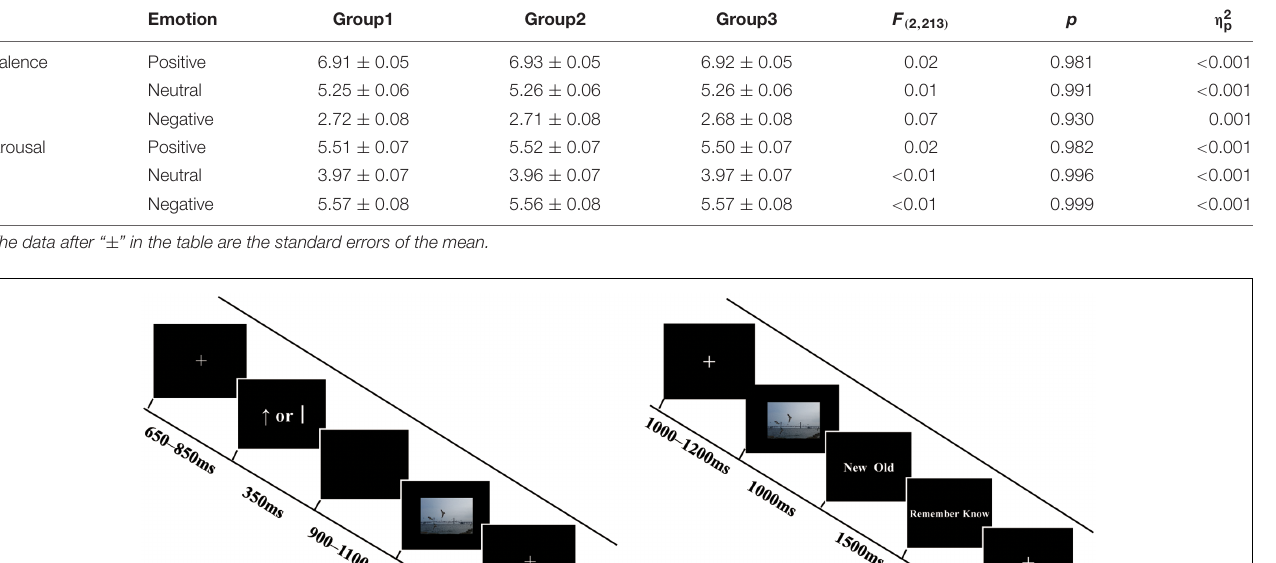
TABLE 1 | The average valence and arousal of the matched three groups in positive, negative and neutral pictures. Emotion Group1 Group2 Group3 F ( 2 , 213 ) η 2 p Valence